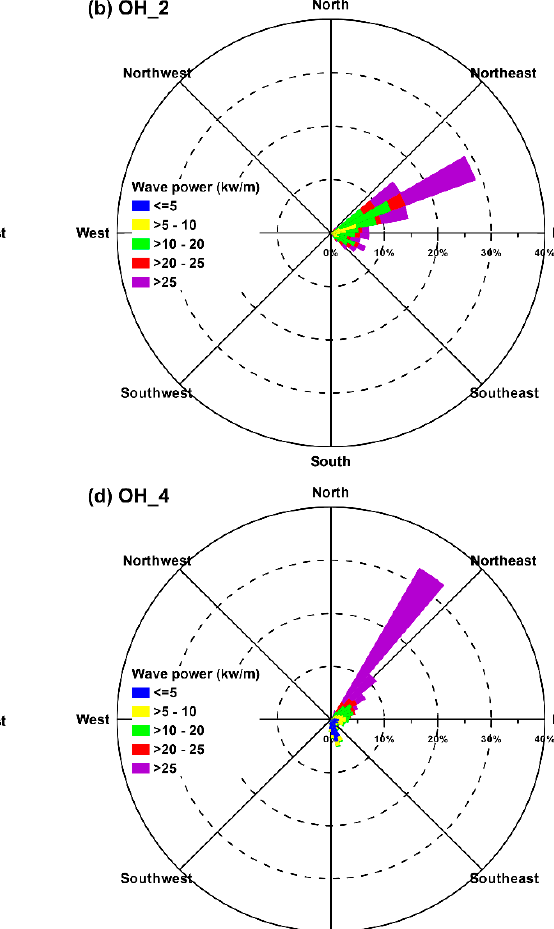
Figure 15. Monthly mean, maximum and minimum wave powers from 1991 to 2010 for four opti-